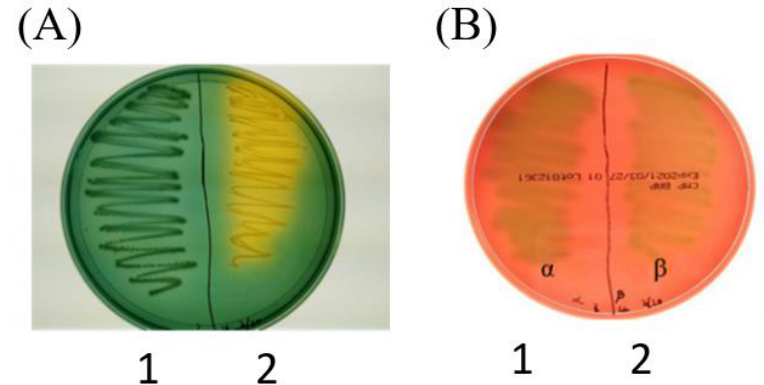
Figure 2. Growth of bacterial isolates on ( A ) TCBS and ( B ) sheep blood agar.